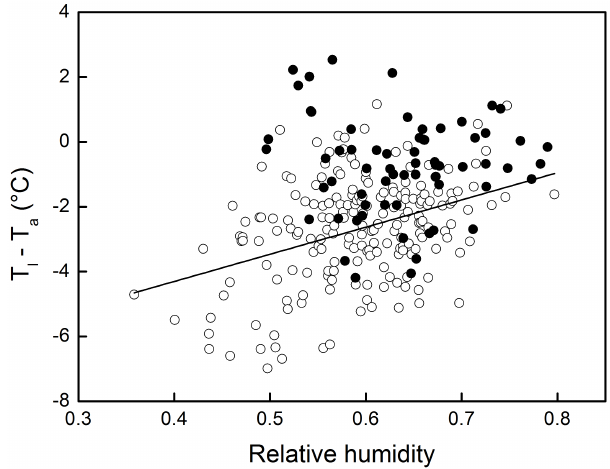
Figure 2. Differences between leaf ( T l ) and air ( T a ) temperature as a function of relative air humidity (RH) measured on a homo- geneous grass stand during 5 heat wave days (1–5 July 2015, Bel- gium). The grass was irrigated daily (white circles), with the ex- ception of 1 day (black circles). The linear regression (white data points only) was significant at p< 0 . 001 ( R 2 = 0.13). The differ- ence between regressions (white vs. black) was significant (AN- COVA; F 1257 = 10.3; p = 0.001; GraphPad Prism). In contrast to the model runs, which focus on one peak air temperature (40 ◦ C) to obtain clean comparisons between differing conditions, the re- lationship presented here contains more scatter because of factors varying throughout the day such as air temperature, incident radia- tion, stomatal conductance and wind